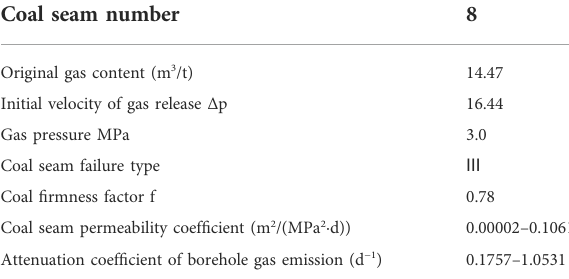
TABLE 4 Basic parameters of coal seam gas in the fi rst mining seam No. 8.